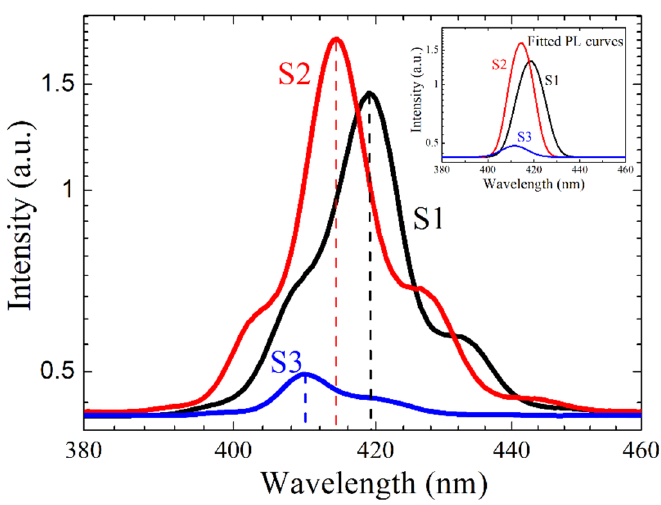
Figure 2. Room temperature PL spectra of all samples. The black, red, and blue dashed lines indicate the peak positions of samples S1, S2, and S3, respectively. The inset shows the fitted PL curves of all samples using the Gaussian function.